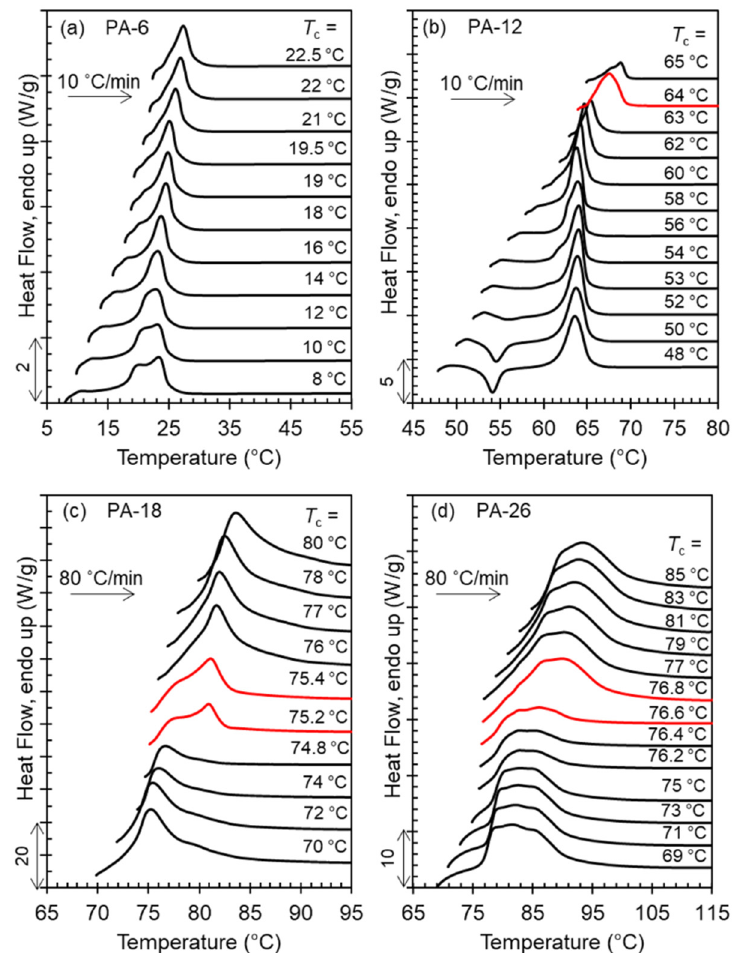
Figure 4. Melting endotherms after isothermal crystallization at indicated T c for ( a ) PA-6, ( b ) PA-12, ( c ) PA-18, and ( d ) PA-26. Melting-recrystallization was minimized by heating at a rate of 80 ◦ C/min for PA-18, and PA-26. The transition from Form I (low melting) to Form II (high melting) is indicated in PA-12, PA-18, and PA-26 by red thermograms. Data have been vertically shifted for clarity.